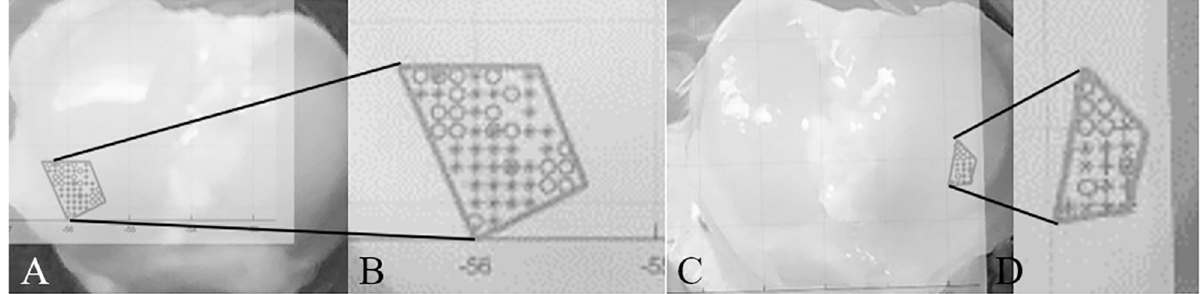
Fig 3. A-D. Photographs of the exposed tibia are shown overlaid with MATLAB graphs of X-Y stage coordinates indicating the locations of the indentations for Subject A’s (A) left knee joint, (B) left knee joint enlarged, (C) right knee joint, and (D) right knee joint enlarged.